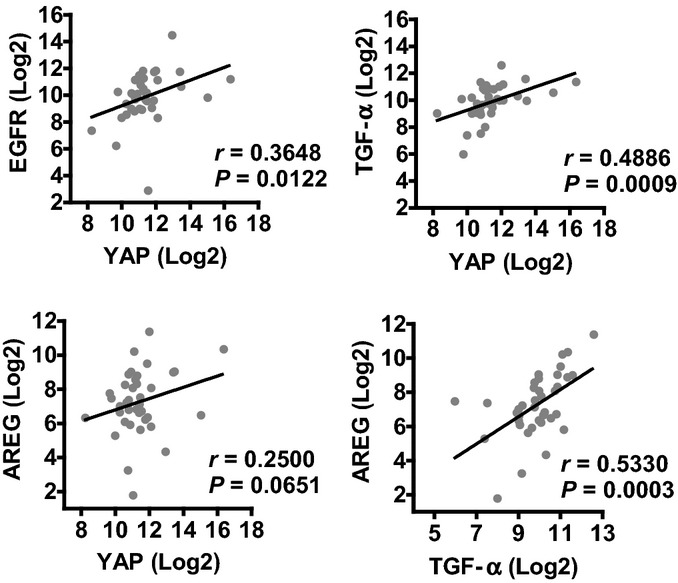
YAP mRNA expression is correlated with TGF-α, EGFR, and AREG in cervical cancer tissuesmRNA expression data (n = 39) were extracted from TCGA RNA sequencing datasets and were analyzed with linear regression analysis in GraphPad Prism 5 (GraphPad Software, Inc., La Jolla, CA). These data indicate that YAP mRNA expression is significantly correlated with TGF-α (P = 0.001) and EGFR (P = 0.0122) mRNA expression. Statistical analysis shows that YAP mRNA expression is not significantly correlated with AREG mRNA expression (P = 0.065). This may be attributed to the limited cervical cancer sample number used for RNA-seq (n = 39). TGF-α mRNA expression is significantly correlated with AREG mRNA expression in examined cervical cancer samples (P = 0.0003).